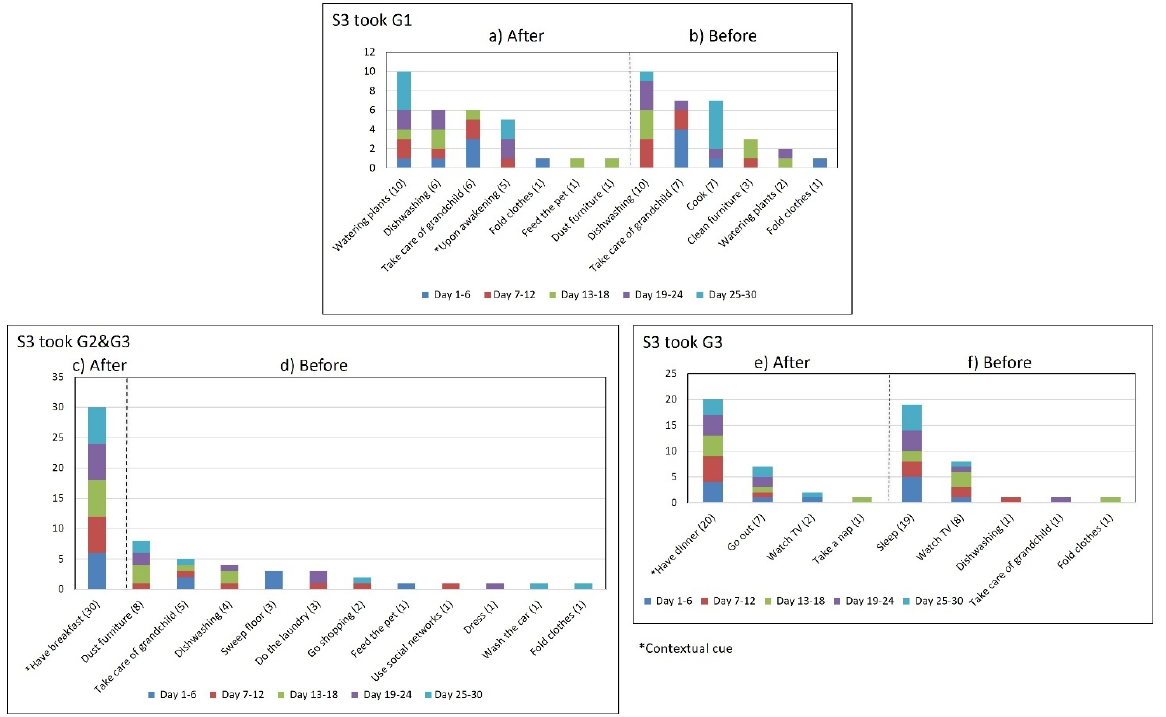
Figure 7. Medication behavior of S3 shows the time of day in which the medication episodes (G1- AM, G2&G3-AM, and G3-PM) were conducted and whether they were associated with the activities set as contextual cues.